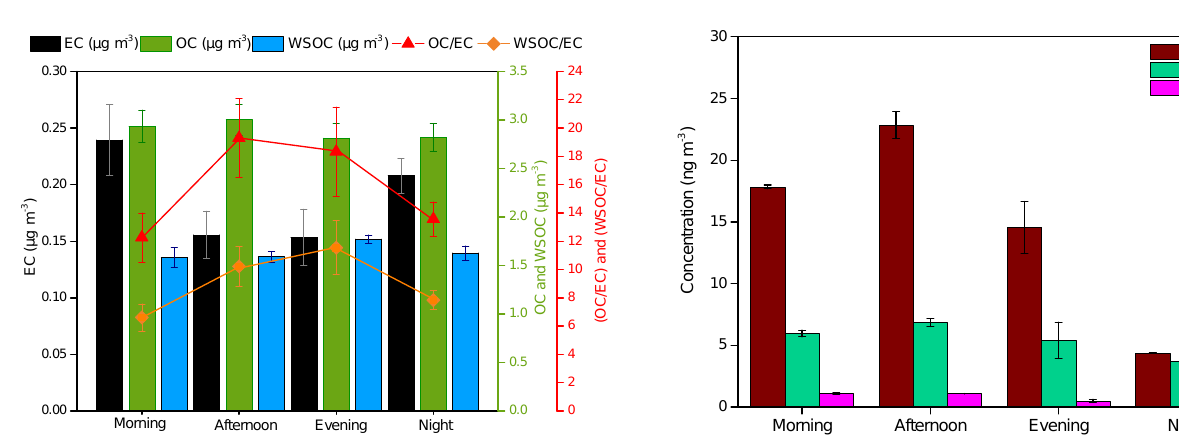
Figure 6. Diurnal trend in the ambient concentrations of metals, i.e., Cu, Fe, and Mn, as measured from the time-segregated integrated filters. Error bars denote standard deviation (1 σ) of the triplicate